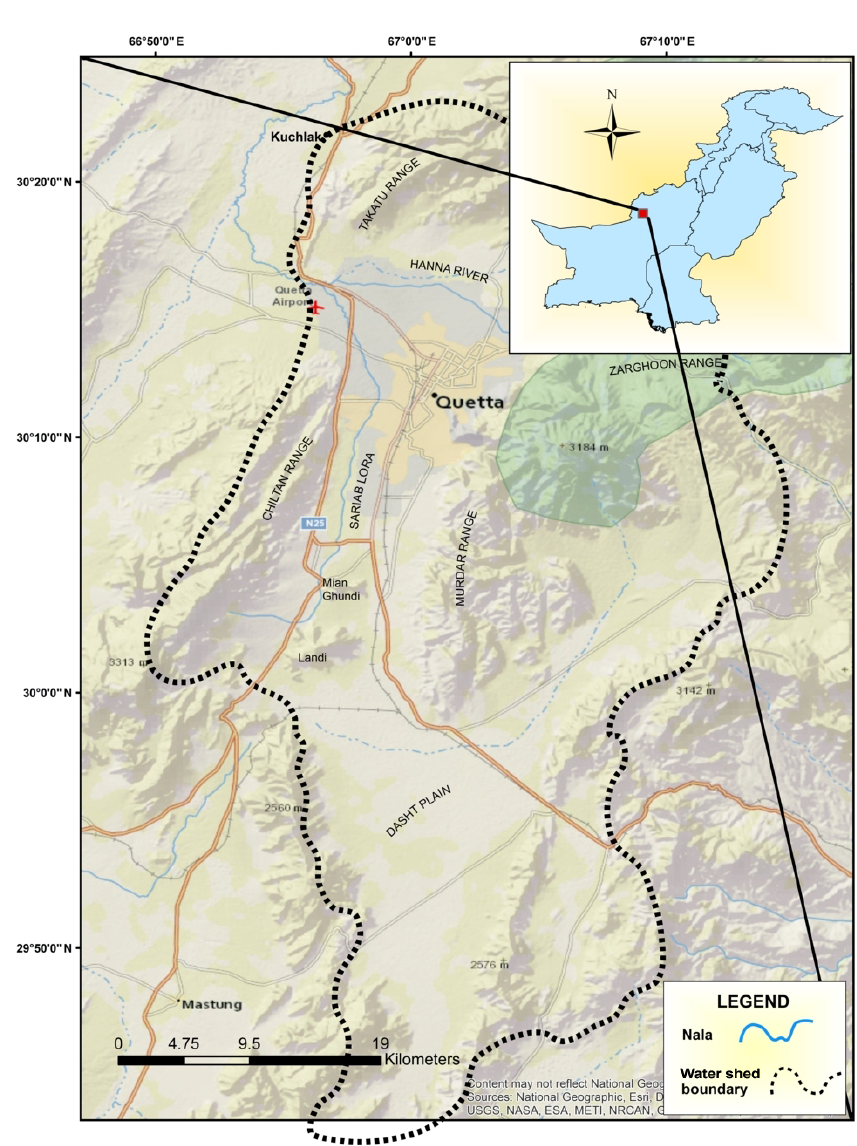
Figure 1. Showing the location of the study area. The watershed boundary of Quetta sub basin is shown by the dotted lines whereas rivers are shown by blue lines. The foundation layer of the map is derived from ©ESRI and open street ArcGIS Online Base